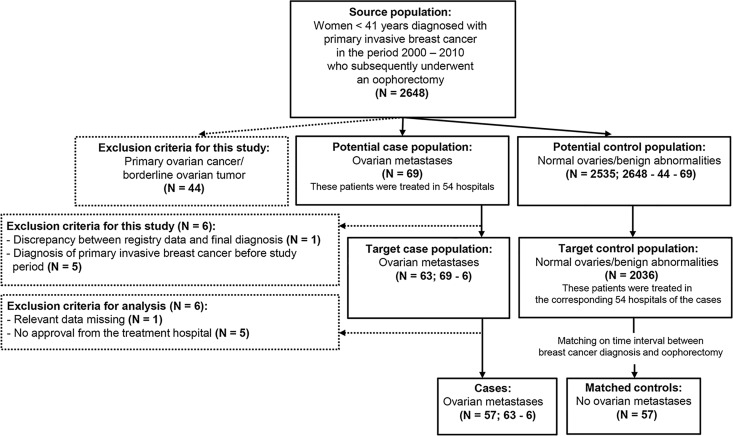
Flow chart of selection of cases and matched controls.The source population was compiled by the Dutch histopathology and cytopathology network. The exclusion criteria are indicated in the dotted boxes.